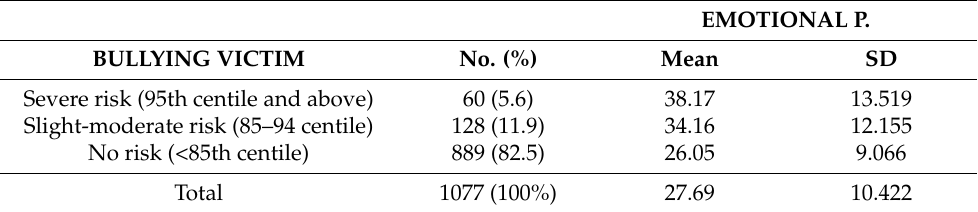
Table 12. Risk of being a victim of bullying and the mean scores on the emotional problems scale.